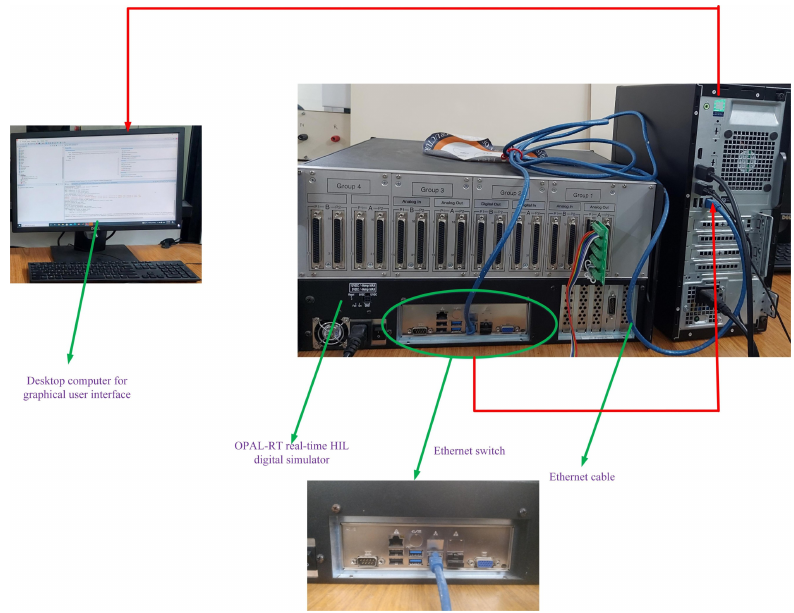
Figure 9. The HIL testing setup.